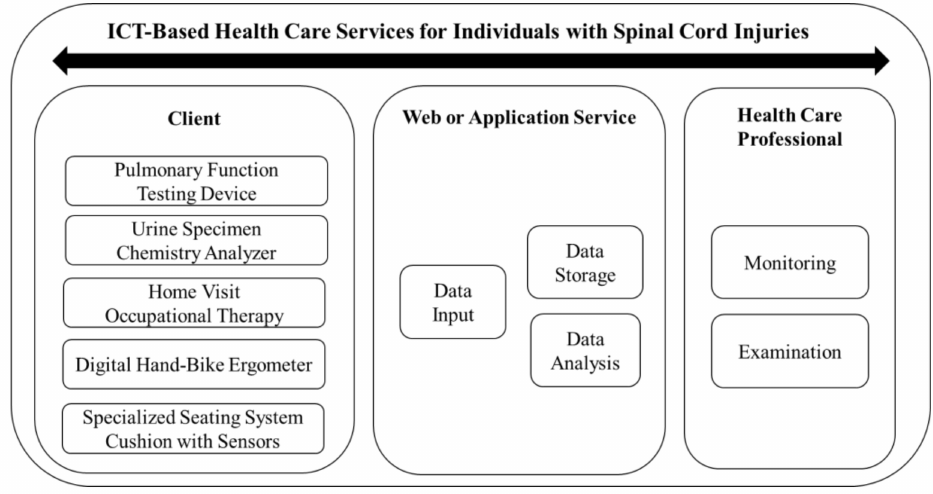
Figure 1. Model of information and communication technology (ICT)-based health care